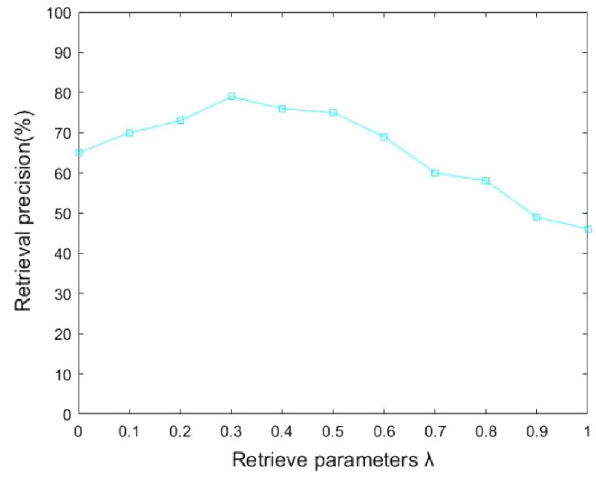
Figure 2. The relationship between parameter (cid:31) and retrieval precision.